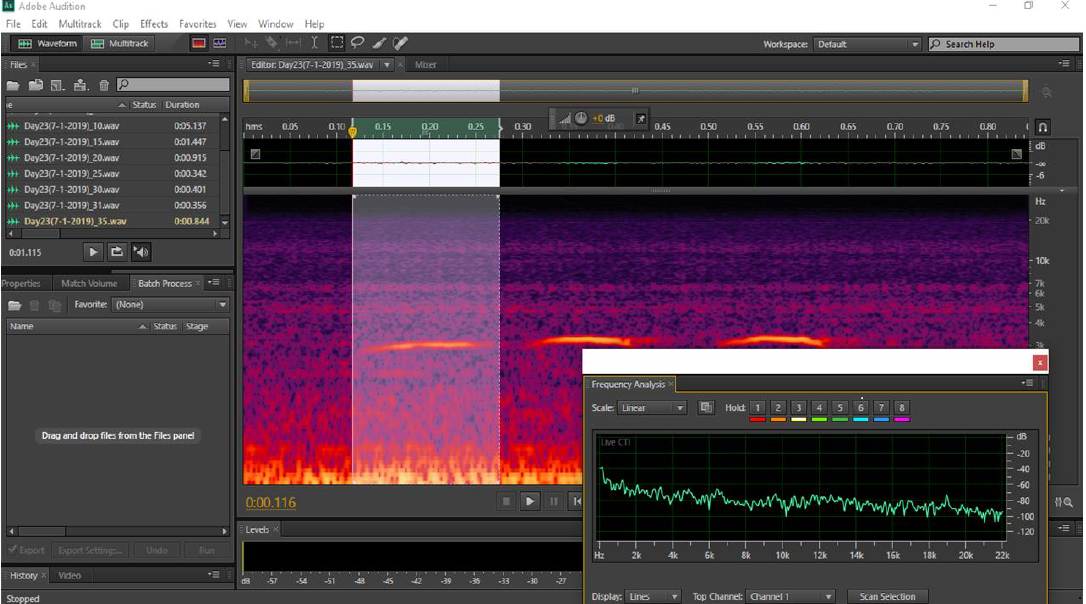
Figure 1. Screenshot of a specific vocalization is highlighted for being analyzed using Adobe ® Audition TM CS6 software (Adobe, San Jose, CA, USA, www.adobe.com). In the window the time-frequency vocalization graph is shown, while the inset represents the frequency analysis.